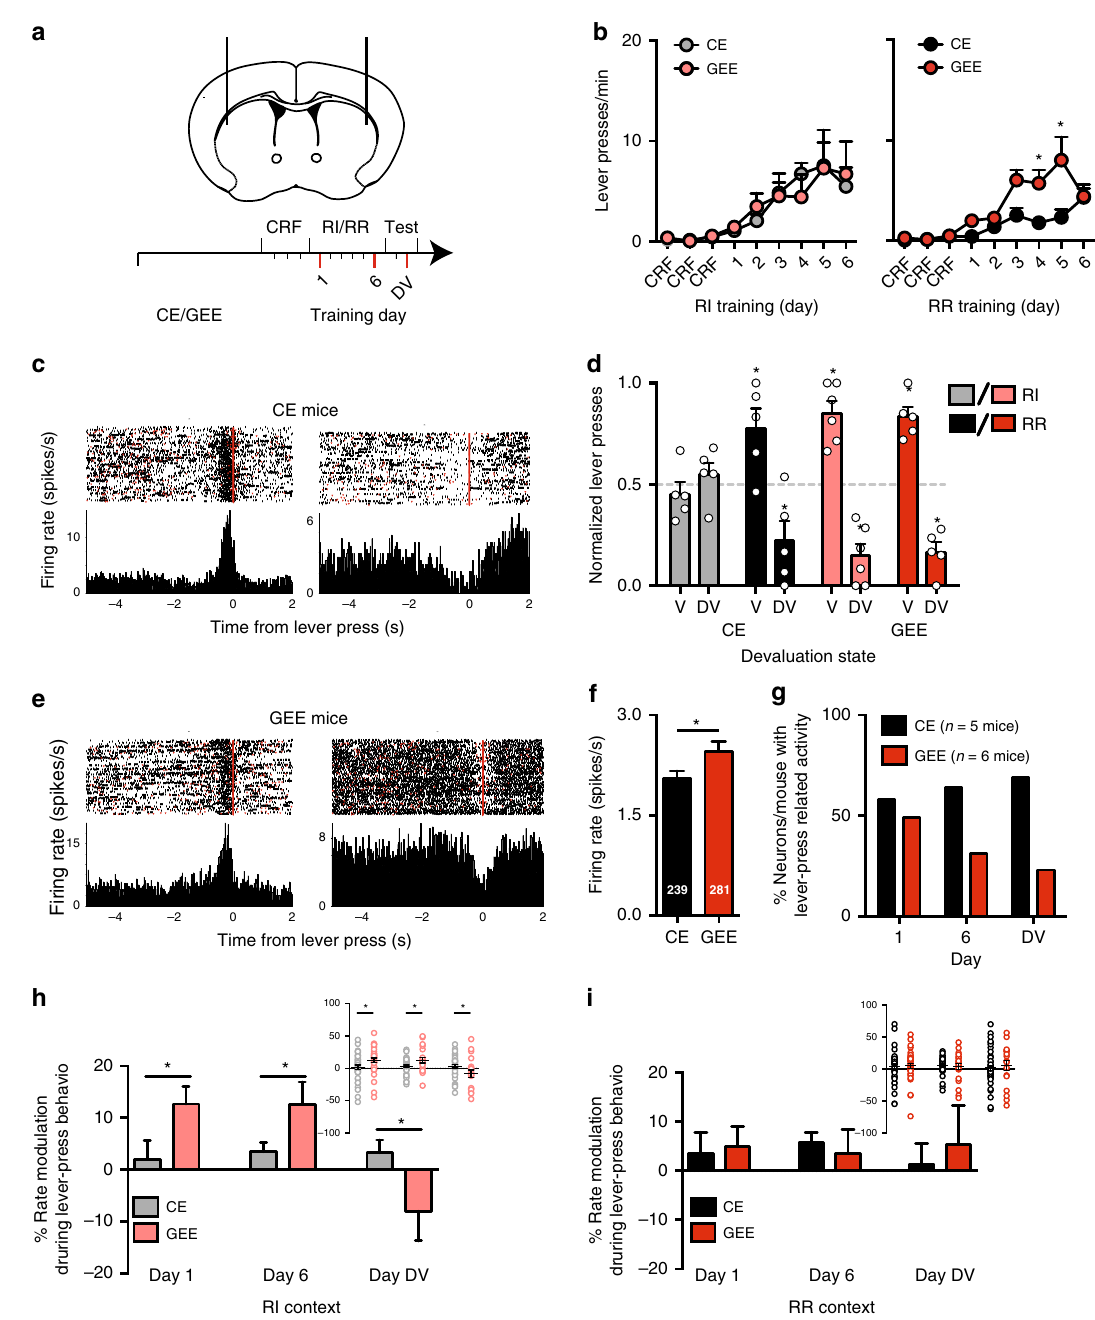
Fig. 3 GEE disrupts in vivo habitual action encoding in DLS circuits. a Schematic diagram showing site of multi-electrode recording in the DLS (black) and DMS (gray), and experimental design. In vivo recordings were made on day 1 and 6 of schedule training and outcome devaluation (DV) testing (marked in red). ( b ) Response rate during RI and RR schedule training for CE and GEE mice that were implanted with multi-electrode arrays. c , e Representative raster plots (top-panel) and peri-event time histograms (bottom-panel) of putative DLS MSNs increasing (left) or decreasing (right) their activity around the lever-press (red line at time 0 (s)) in CE ( c ) and GEE ( e ) mice. Each row in the raster is neural activity + 5 to − 2 s around a lever press (time = 0 s, red line). Trials are sorted according to the order of lever-presses made across the session. The peri-event time histogram shows the average fi ring rate during lever-press related behavior. d Normalized lever-pressing in RI and RR trained contexts during outcome revaluation testing in Valued (V) and Devalued (DV) states in CE and GEE mice implanted with multi-electrode arrays. f Baseline fi ring rate of putative DLS MSNs that fi red in both RI and RR training contexts in CE ( n = 239) and GEE ( n = 281) mice. g Proportion of putative DLS MSNs per animal that changed fi ring rate during lever-pressing under RI and RR schedules during training (day 1 and day 6) and following outcome devaluation. h , i The % rate net modulation during lever-press related behavior of fi ring rate in CE and GEE mice in h RI and i RR contexts. Inset shows percentage rate modulation distribution of individual units on Days 1, 6, and DV. Error bars equal ± SEM, * = p <